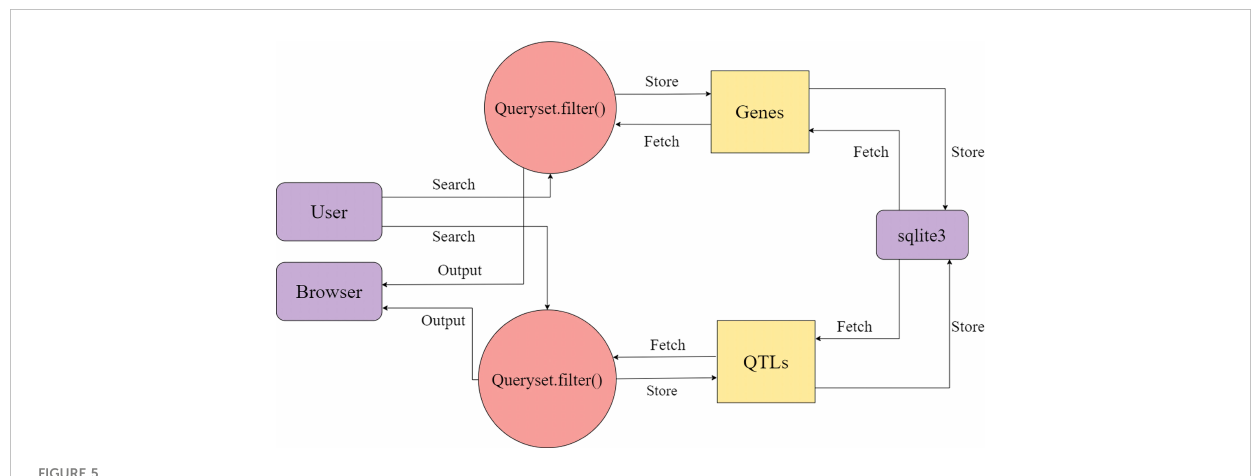
FIGURE 5 Depicting the data fl ow diagram of the